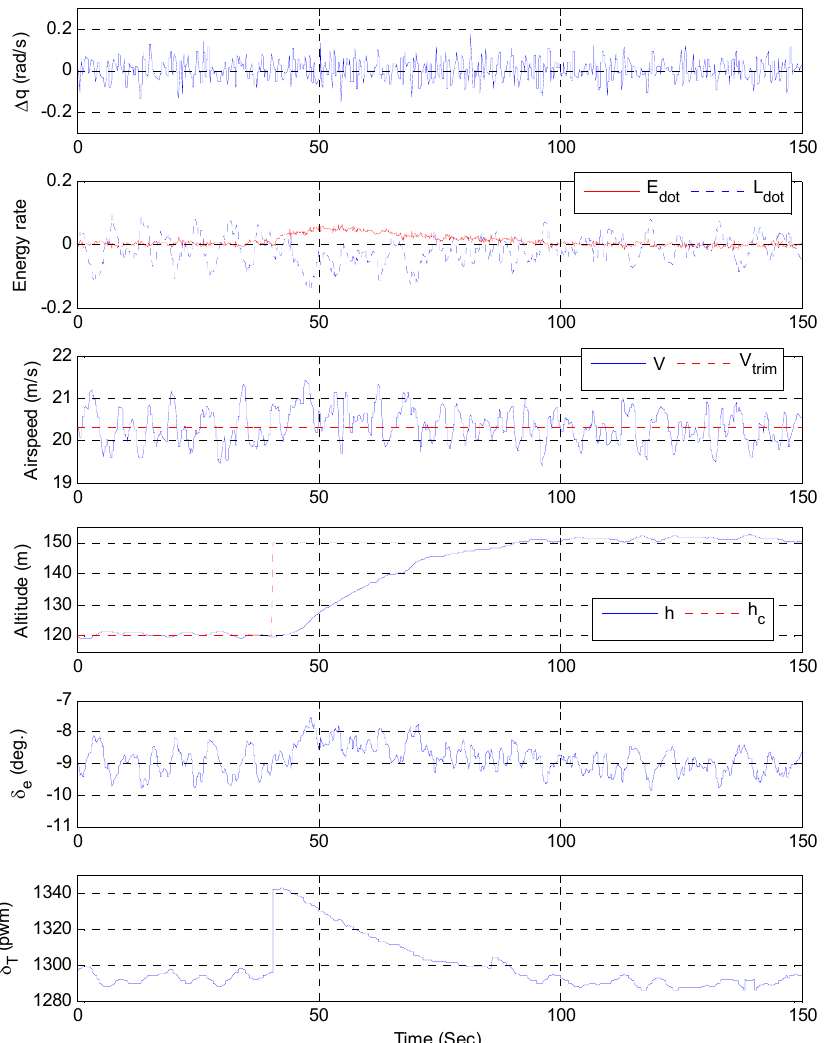
Figure 16. Simulation results of climbing with the presence of wind.